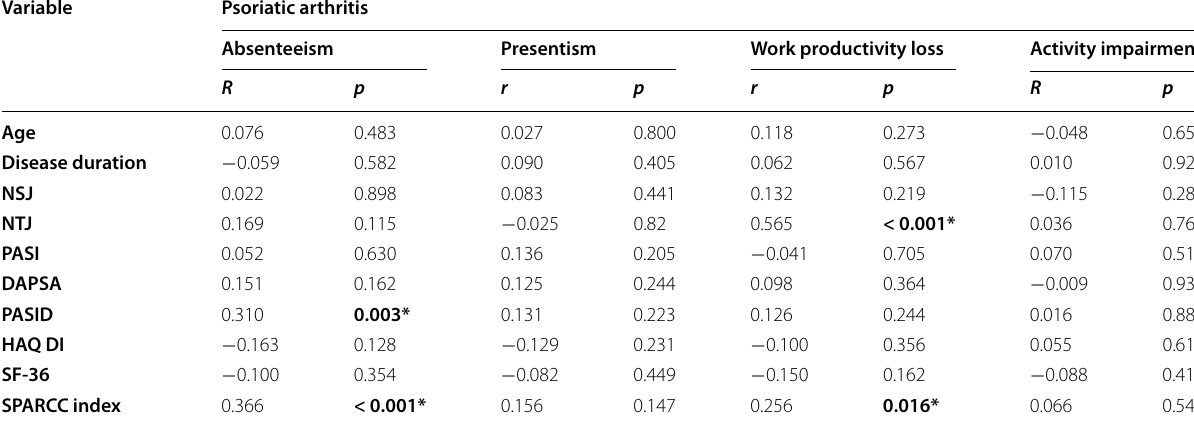
Table 6 Correlations of work impairment with different disease parameters in PSA patients